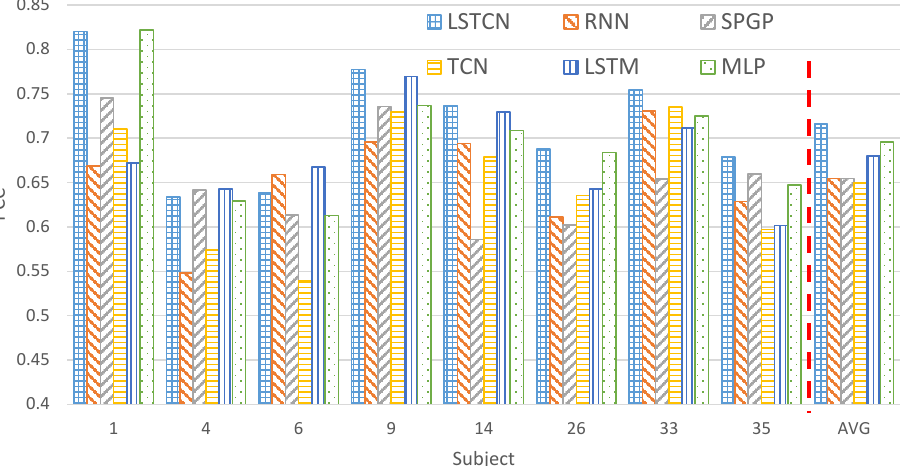
Figure 7. Summary of the PCC of 8 subjects. PCC denotes the correlation between predicted joint angles and real joint angles. The higher, the